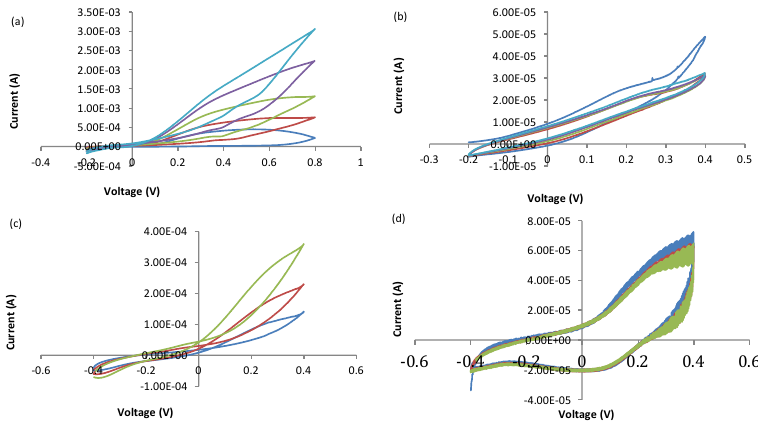
Figure S6 : Measurement of gold electrode functionalization by CV: with (a) DNA, O-PD and AuNPs, (b) thick gold layer, (c) carbon nano tubes and (d) CNT embedded in chitosan. Each CV colours represent a different cycle . Changes to CV curves in (a) and (d) indicate some instability. Scan rates for all measurements were 150 mV/s.